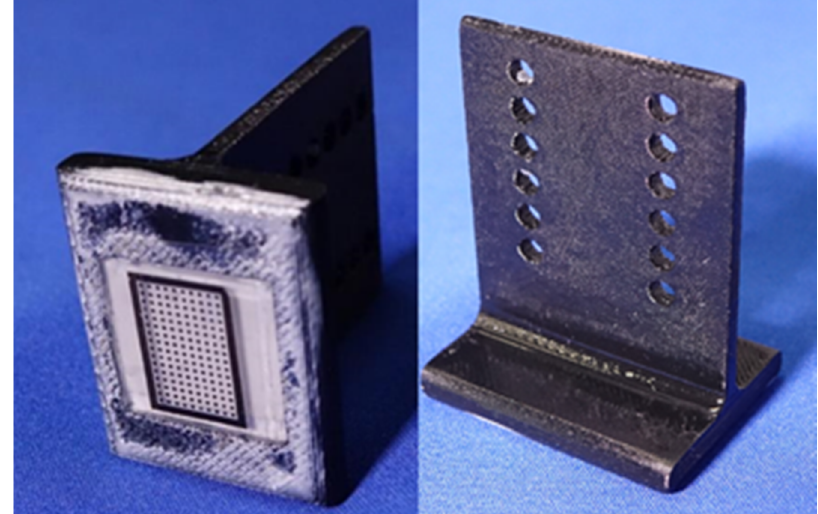
Figure 8. Artificial finger with markers printed on oil-proof paper.